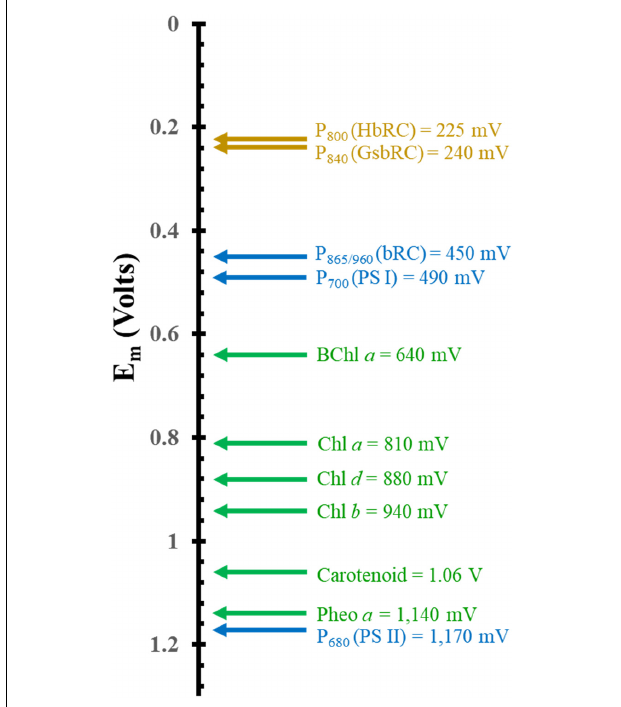
FIGURE 3 | Comparison of the mid-point potential of a variety of (B)Chls in vitro and primary donors in vivo . Isolated in vitro values are depicted in green and hetero and homodimeric primary donors are in blue and dark yellow,